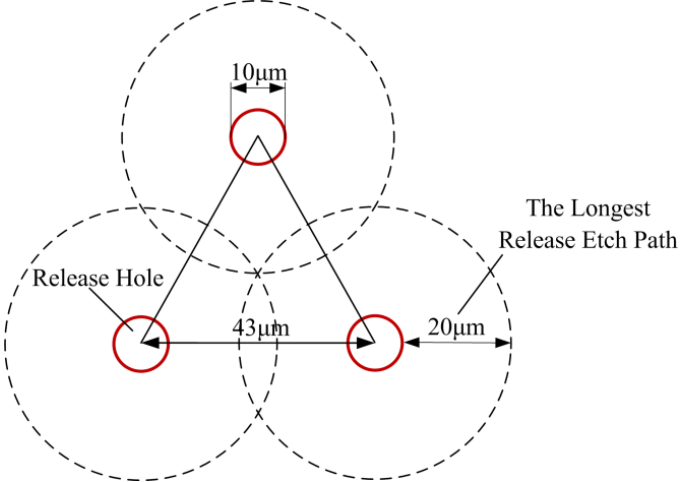
Figure 3. Schematic structure of the release hole